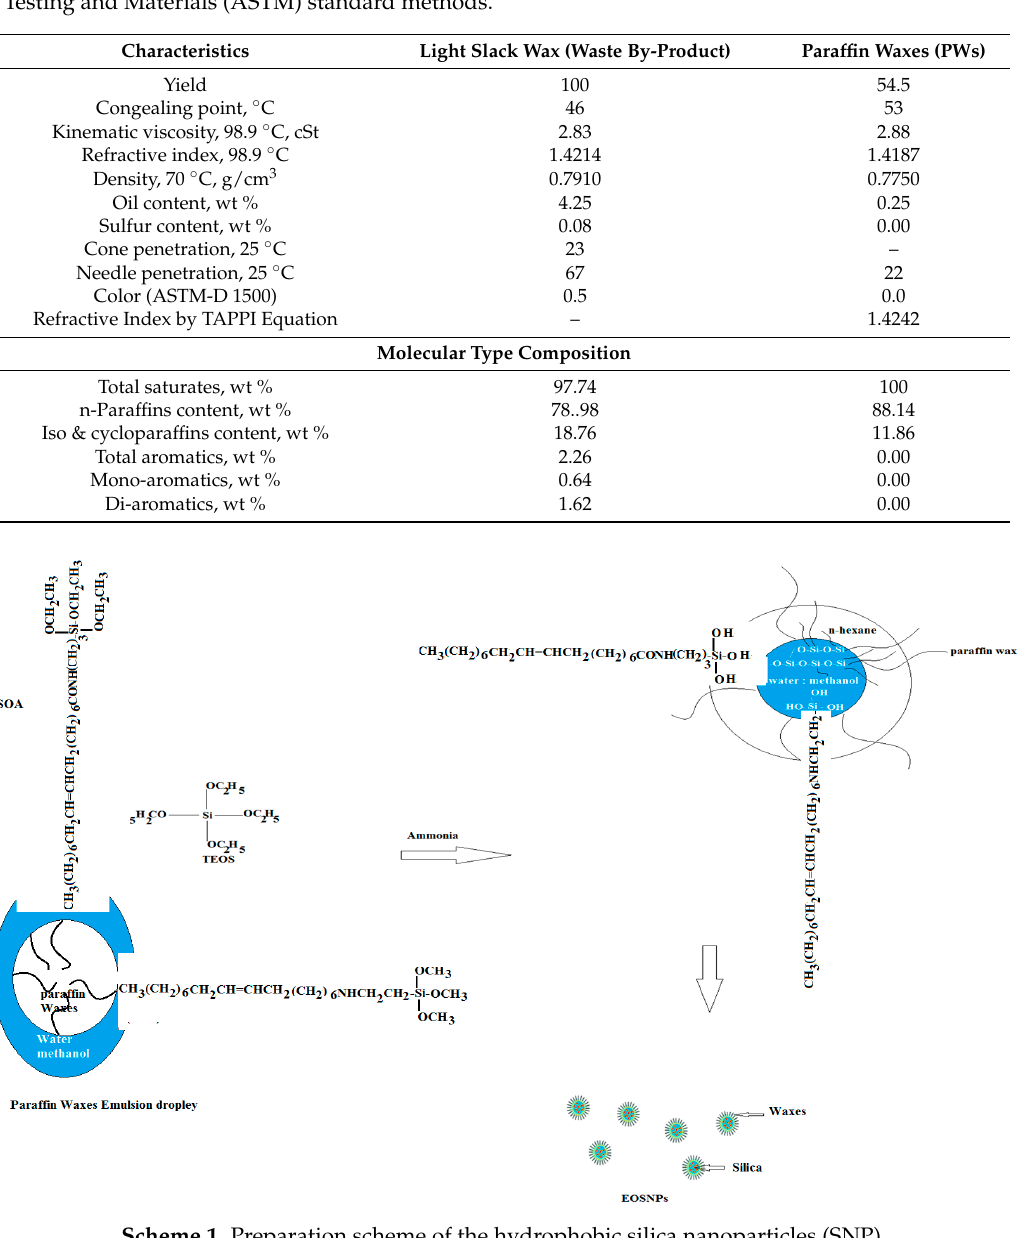
Table 1. Physical characteristics of the El-Ameria light slack wax according to American Society for Testing and Materials (ASTM) standard methods.